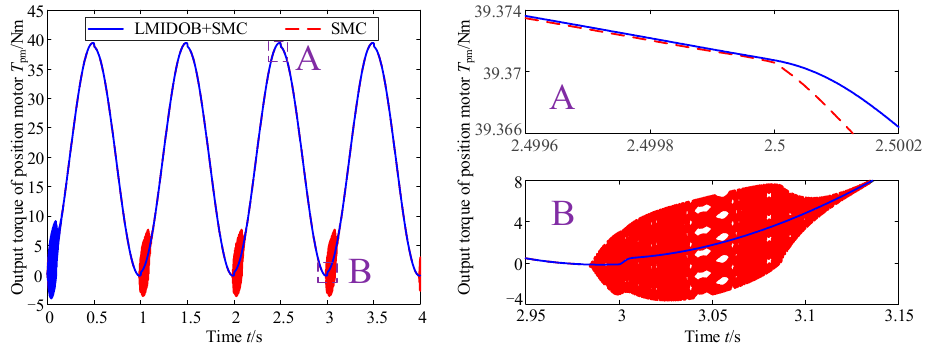
Figure 8. Output torque of position motor at a constant stiffness condition.